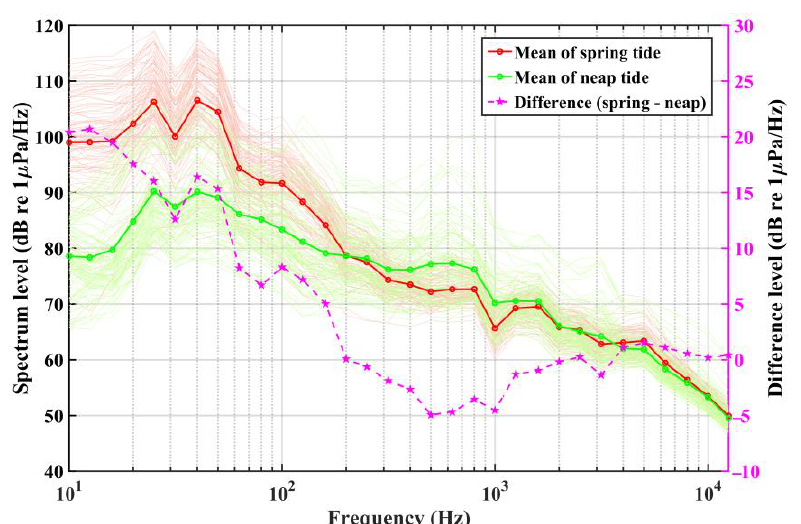
Figure 4. Frequency spectra of underwater noise during spring and neap tide periods. The thick solid lines represent the average frequency spectra of underwater noise during the spring tide (red) and neap tide (green). The magenta line indicates the differences between the two average frequency spectra.